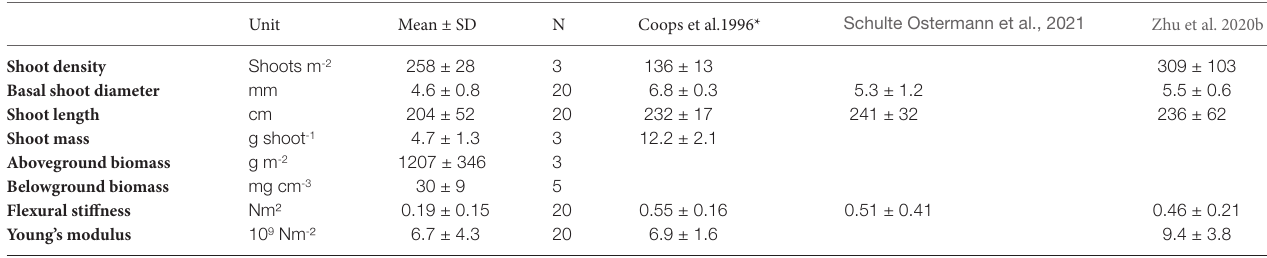
TABLE 3 | Aboveground and belowground properties of reed vegetation (left) at the monolith extraction sites presented as the mean, standard deviation ( SD ) and sample size ( N ) and (right) compared to peak biomass measurements in literature ( mean ± SD